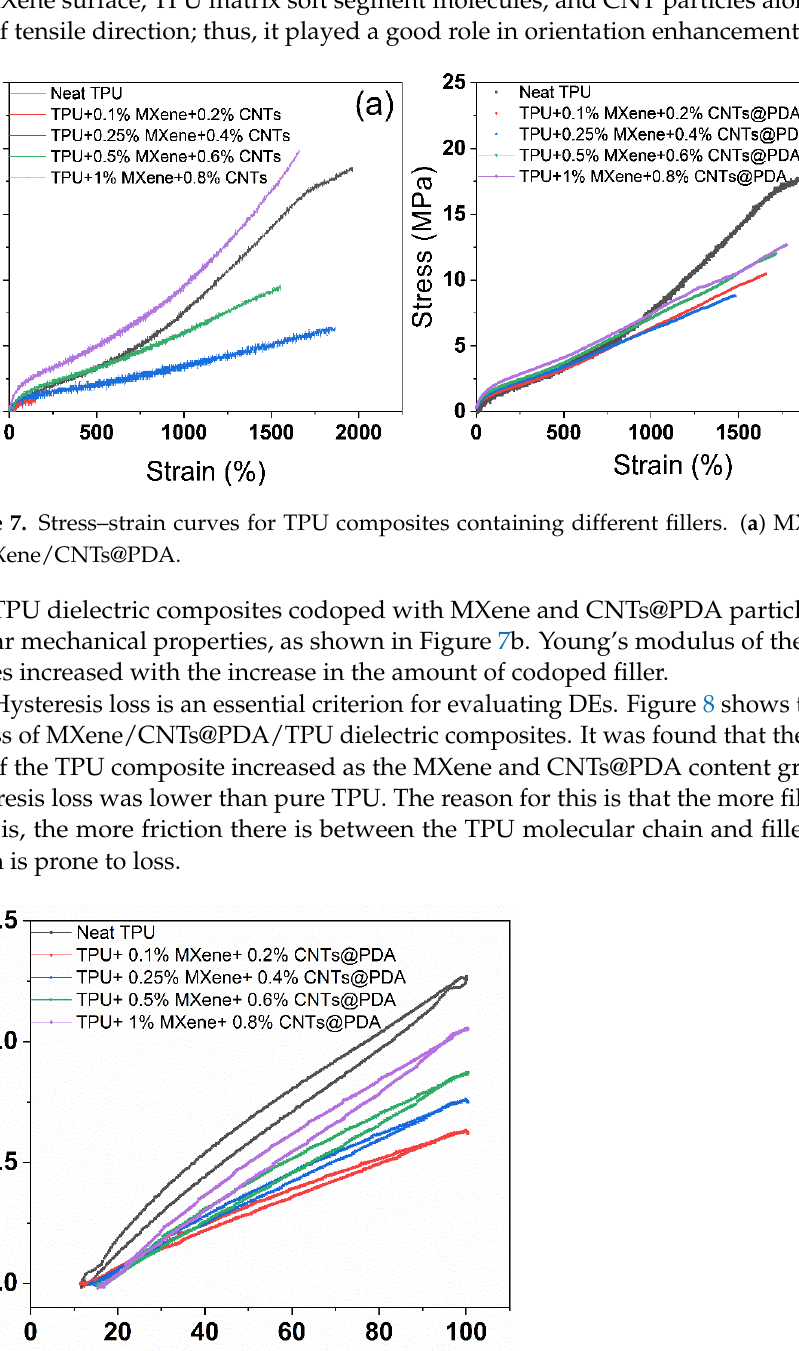
Figure 8. The hysteresis loss properties of TPU composites codoped with MXene and CNTs@PDA.